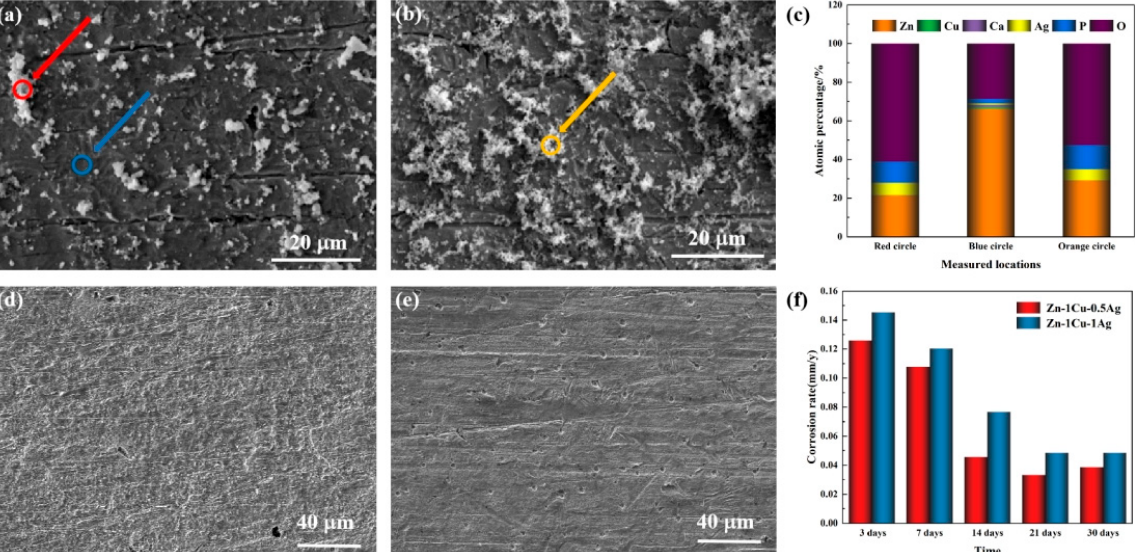
Figure 4. The corrosion morphologies of ( a ) the Zn-1Cu-0.5Ag and ( b ) the Zn-1Cu-1Ag alloys after 30 days immersion in SBF solution; the corroded surface of ( d ) the Zn-1Cu-0.5Ag and ( e ) the Zn-1Cu-1Ag alloys after removal of corrosion products; ( c ) EDS point analysis results taken from the hollow circles in ( a , b ); ( f ) corrosion rates of the Zn-1Cu-xAg alloys.